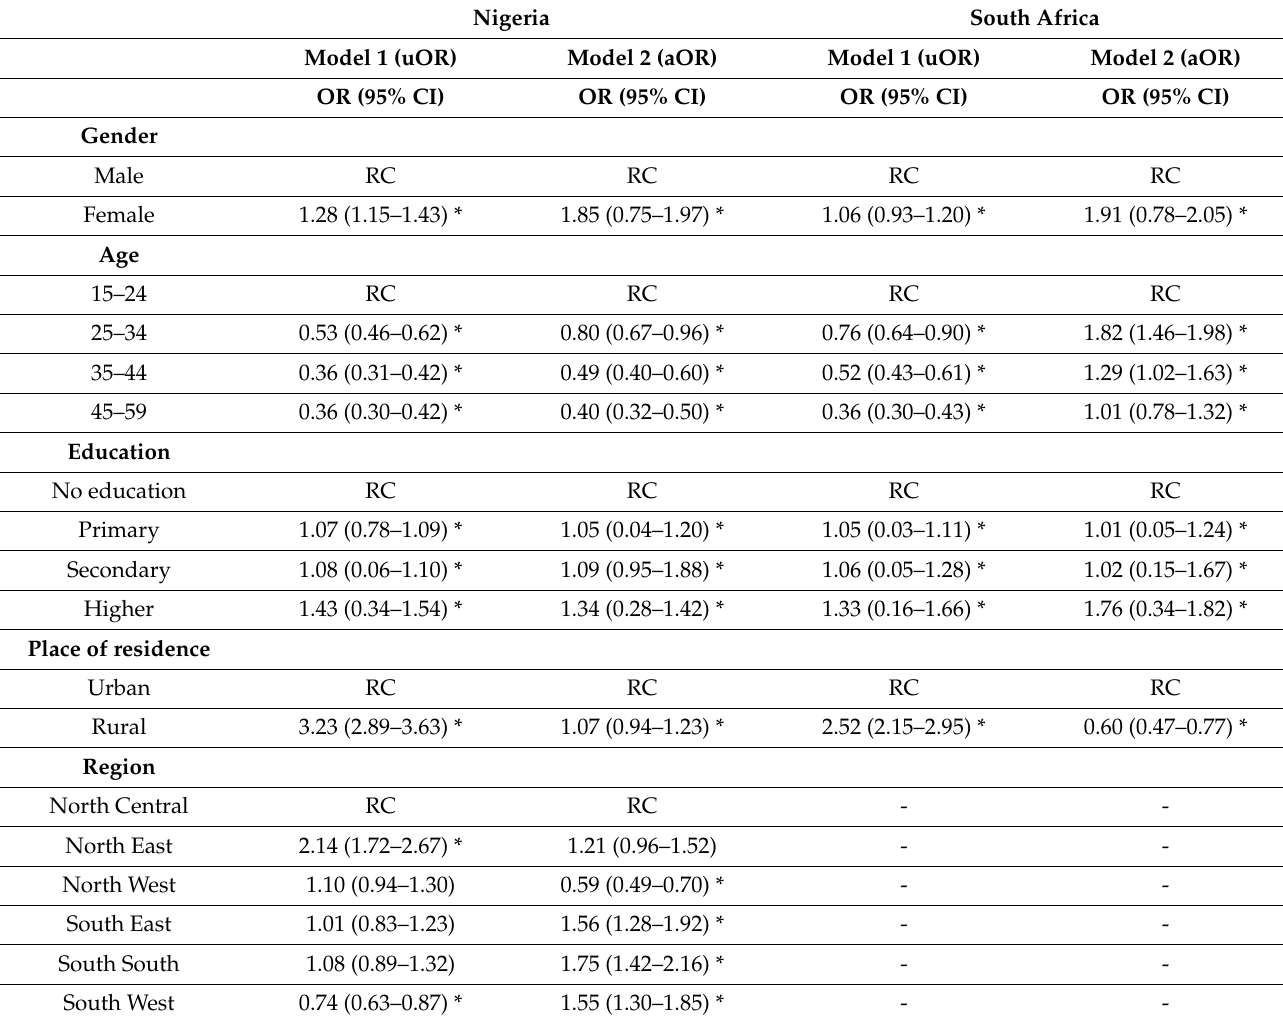
Table 4. Logistic regression analysis identifying associations between socio-demographic factors and health insurance coverage in Nigeria and South Africa. Nigeria South